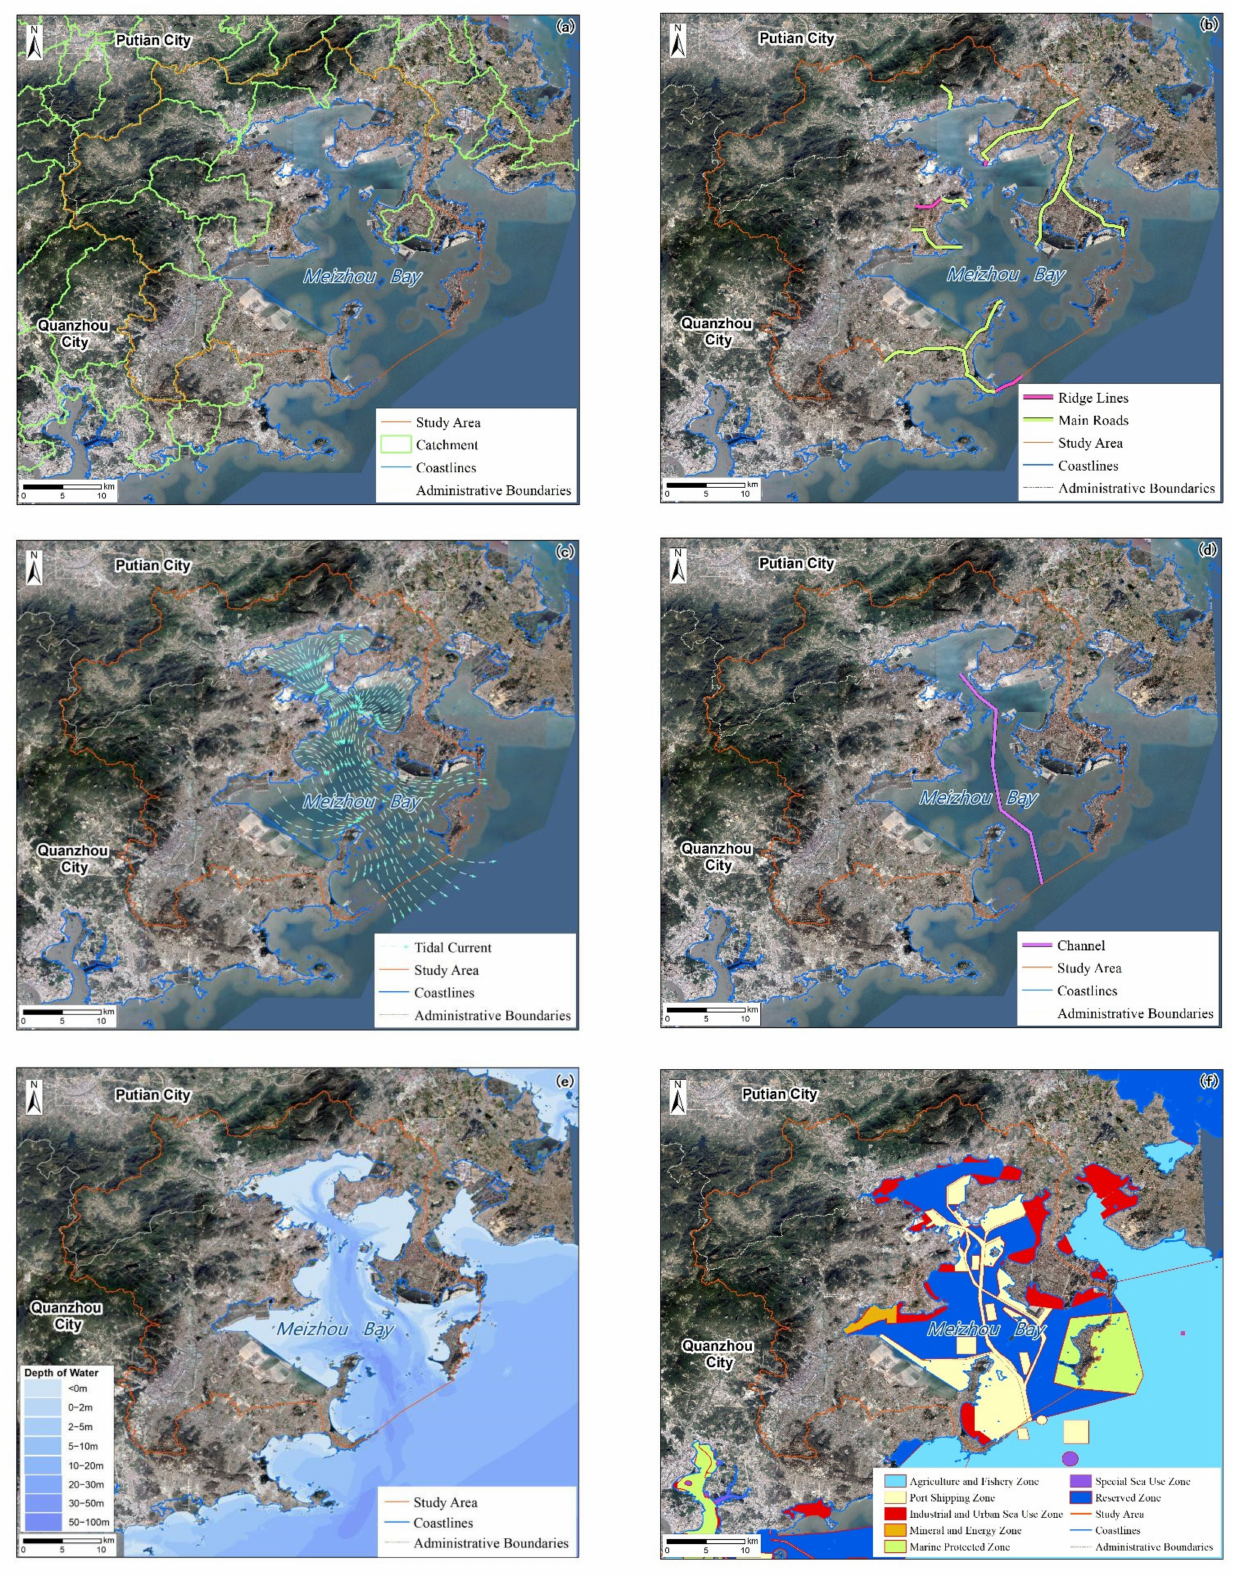
Figure 3. The delimitation of subregion boundaries: ( a ) catchment units; ( b ) ridge lines and main roads; ( c ) trends of tidal currents; ( d ) channel trends; ( e ) water depth; and, ( f ) zonal boundaries of Marine Functional Zoning of Fujian Province